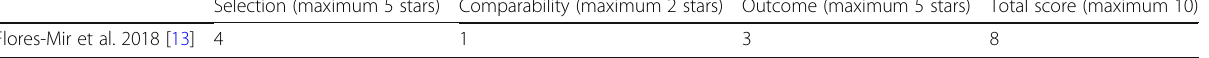
Table 2 Risk of bias of the studies, according to the Newcastle-Ottawa Scale adapted for cross-sectional studies